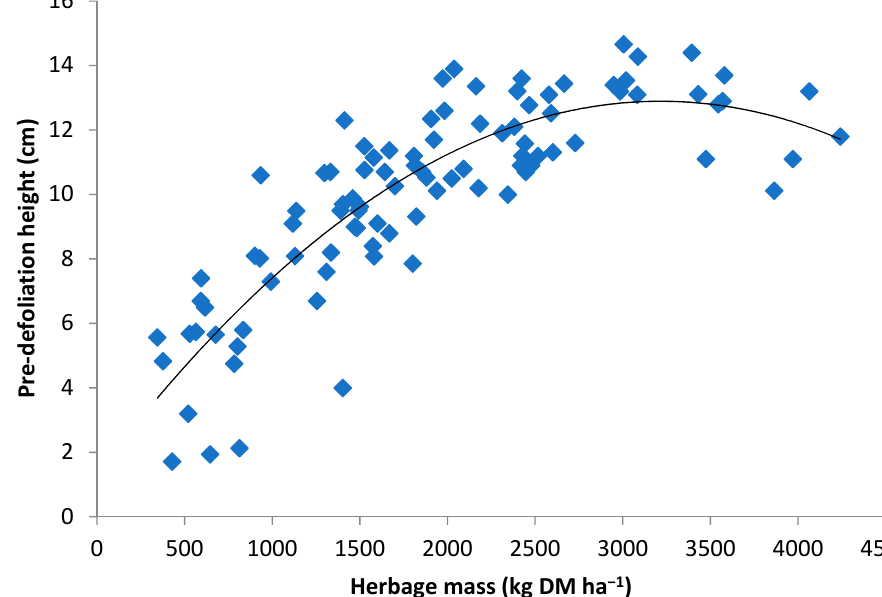
Figure 1. The relationship between the herbage mass (kg · DM · ha − 1 ) and the pre- defoliation height for autumn defoliation. The relationship is described by the equation y = − 1 × 10 − 6 x 2 + 0.072x + 1.34. R 2 =